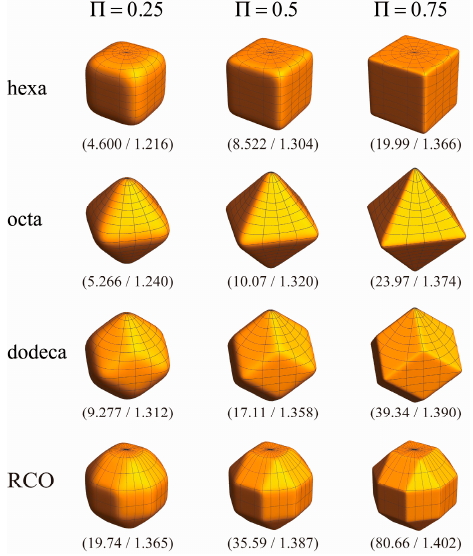
Figure 5. The shapes of the hexahedral, octahedral, dodecahedral and RCO superspheres at various values of Π . The values in a parenthesis separated by a slash are those of p ( left ) and η ( right ) for each shape.